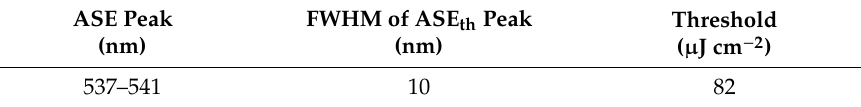
Figure 5. ( a ) Pump–fluence relationship and ( b ) Integrated PL intensity vs. pulse energy density, for the CsPbBr 3 / PMMA thin disk. Table 4. ASE parameters of the CsPbBr 3 / PMMA thin disk.